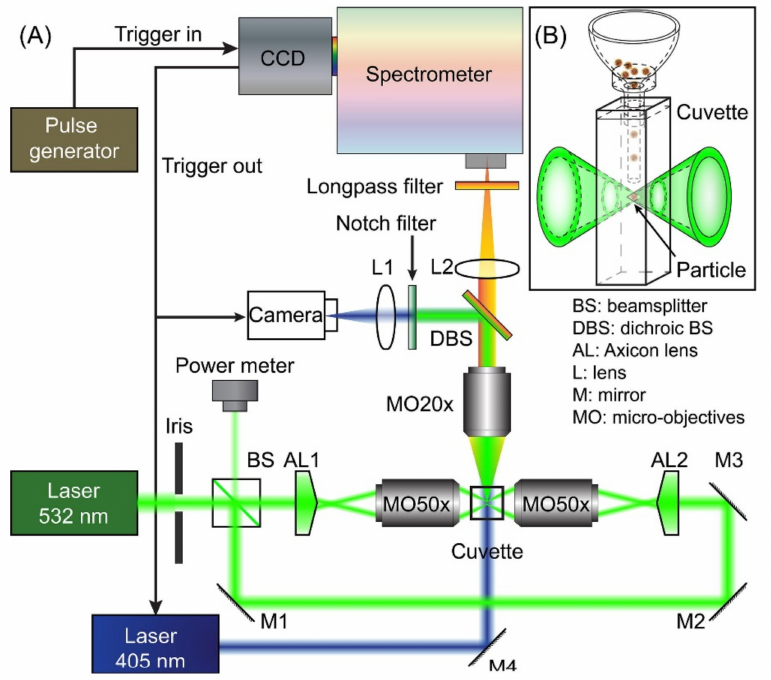
Figure 8. The experimental setup. ( A ) The OT-RS system based on two counter-propagating hollow beams for trapping and characterizing both absorbing and transparent particles. ( B ) The detailed particle introduction setup and the hollow optical trap. (Reprinted with permission from [181]. Copyright (2107)